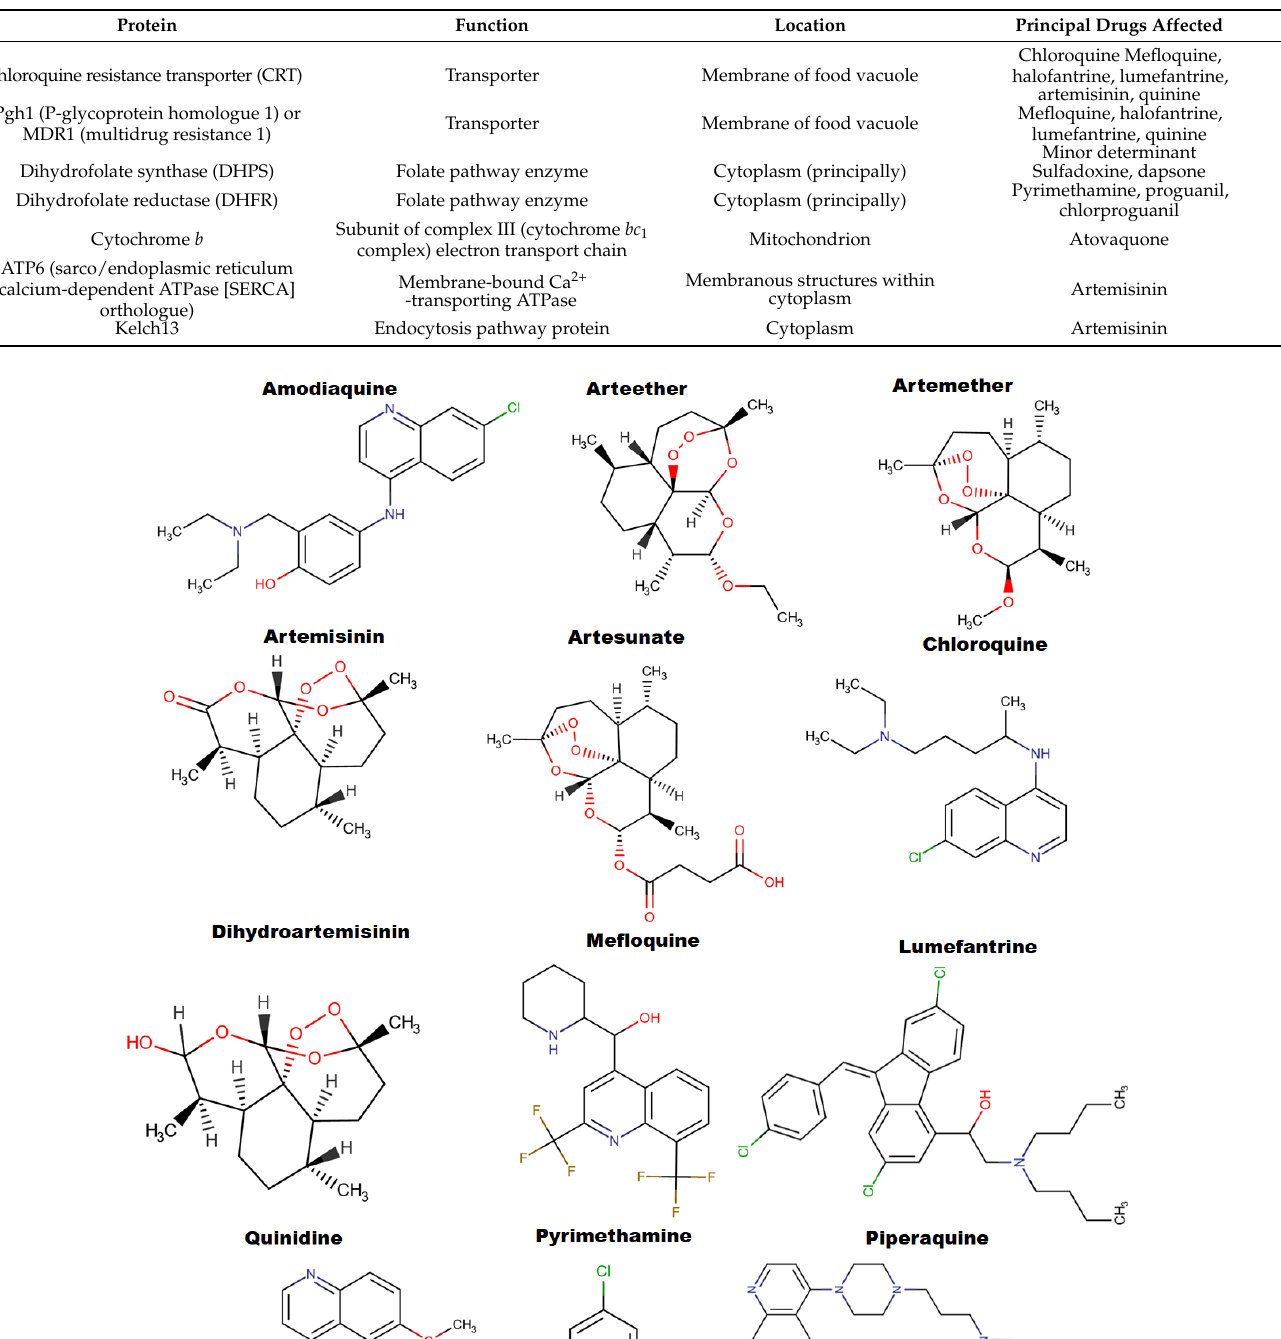
Table 2. List of proteins in plasmodium which has been implicated in the resistance of antimalarial chemotherapy.